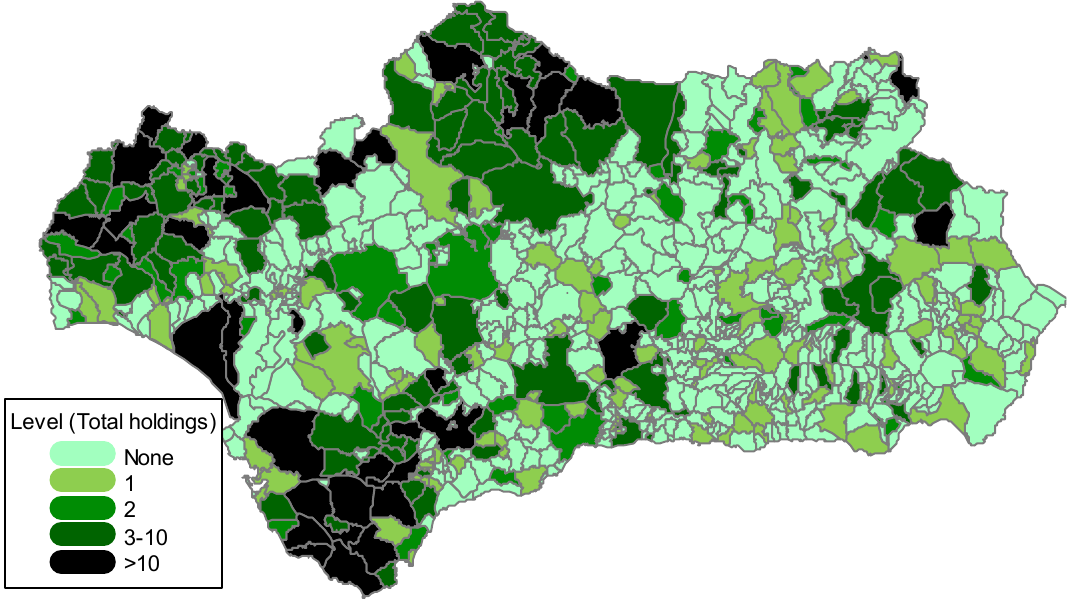
Figure 1. Spatial distribution of total organic livestock farms by municipalities. As the frequencies of appearance are very low, presenting asymmetry, with a standardized skewness of 63.65, fitting with the Waring distribution is appropriate.